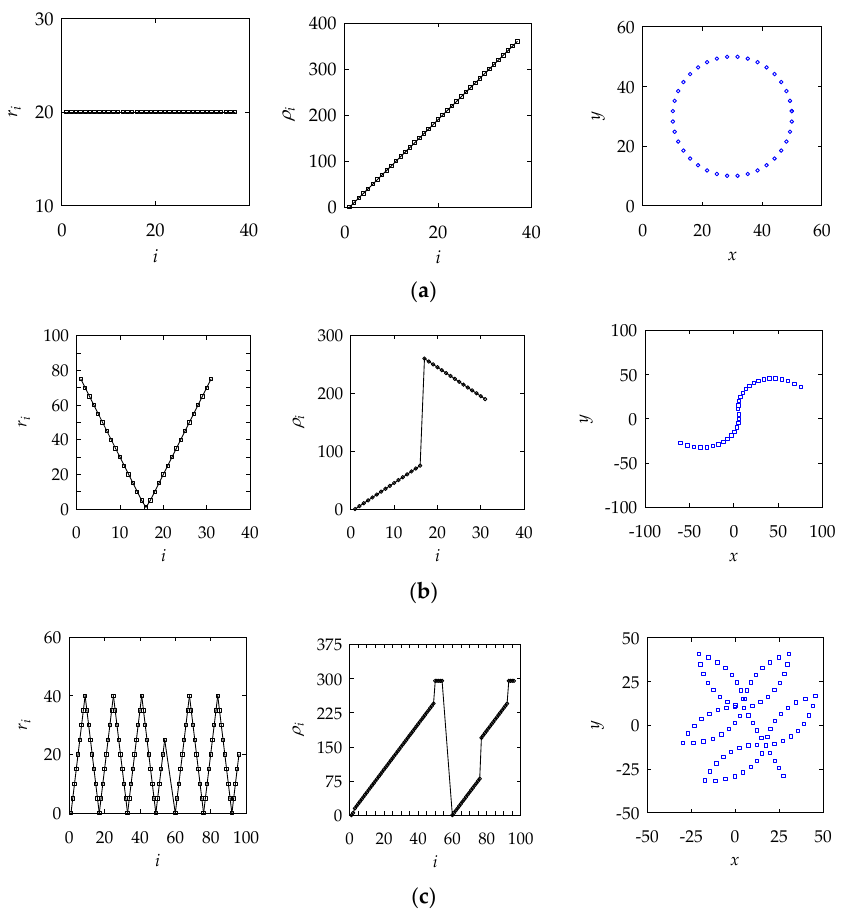
Figure 7. Point-cloud created by using the algorithmic approach. ( a ) Circle; ( b ) Curvy shape; ( c ) Leaf.